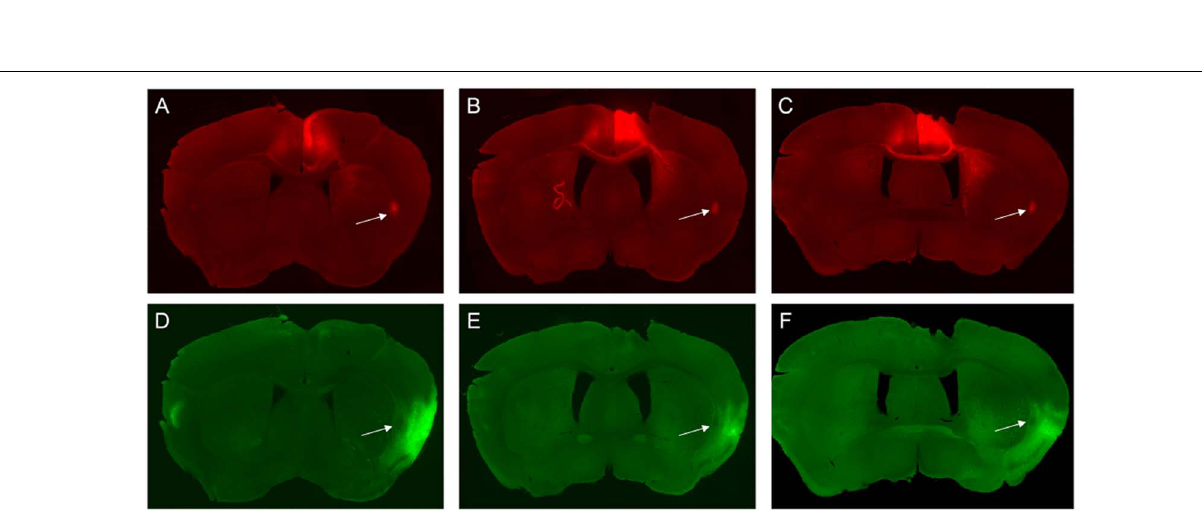
Frontiers in Neuroanatomy |